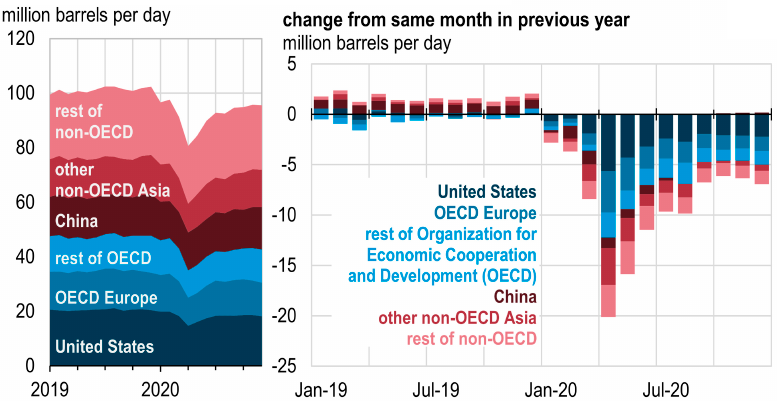
Figure 4. COVID-19 caused a significant fall in global oil demand in 2020, EIA [10].